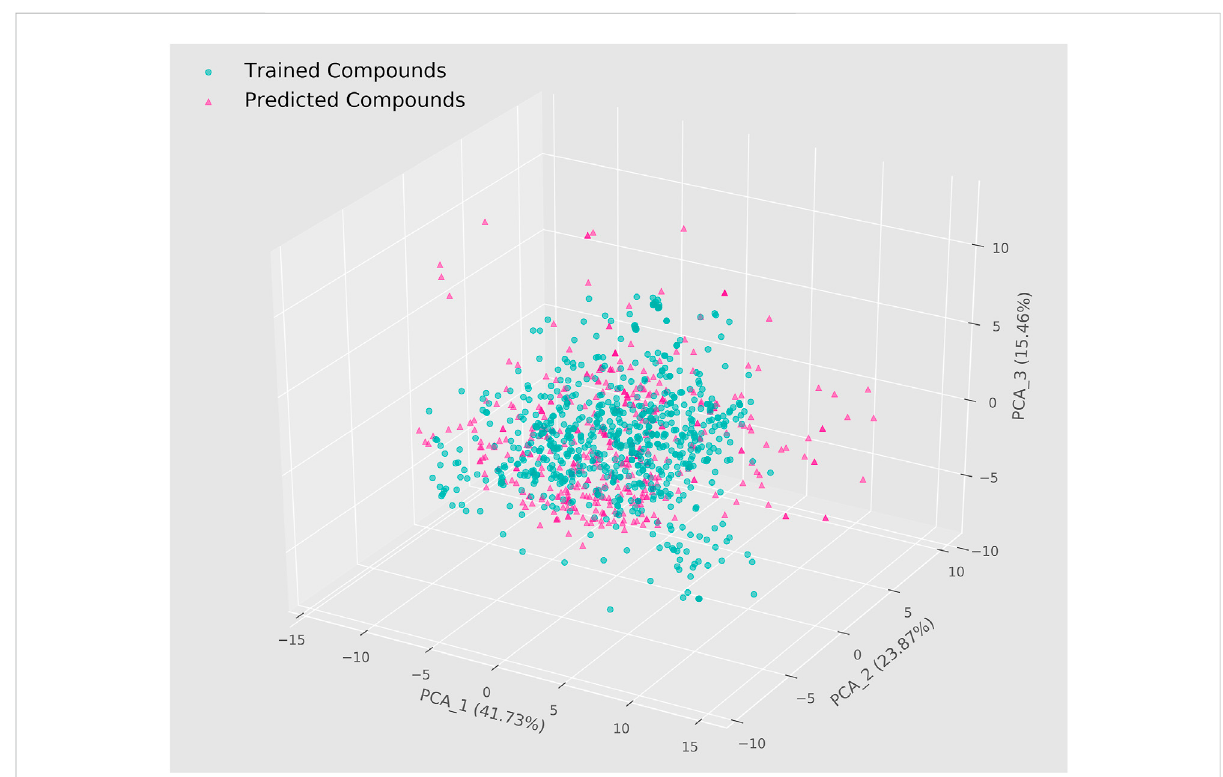
FIGURE 3 Chemical spatial distribution of trained compounds and predicted